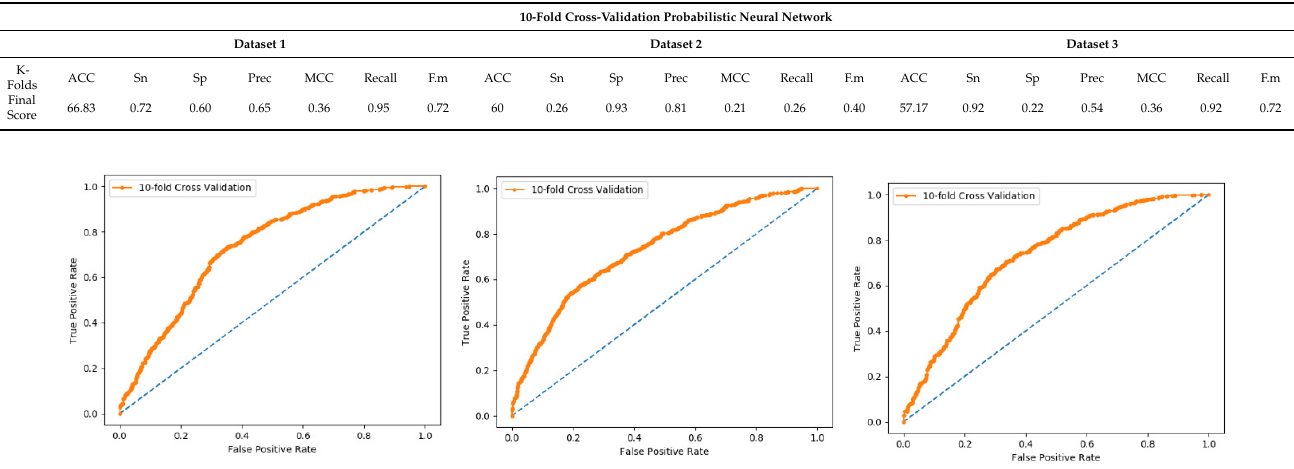
Table 4. Jackknife test score based on Random Forest. Figure 7. Ten-fold Probabilistic Neural Network ROC curve.